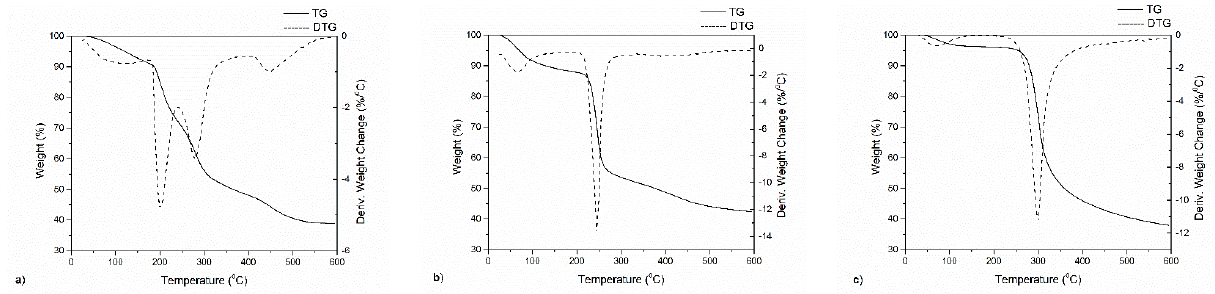
Figure 8. TG-DTG thermograms of CCCA ( a ), NaALG ( b ) and CT ( c ).